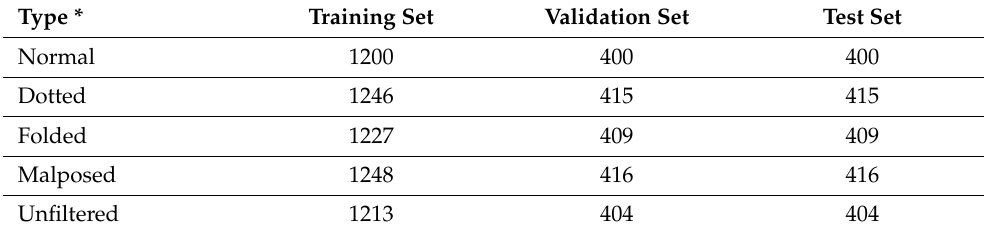
Table 1. The division of the data set of cigarette appearance